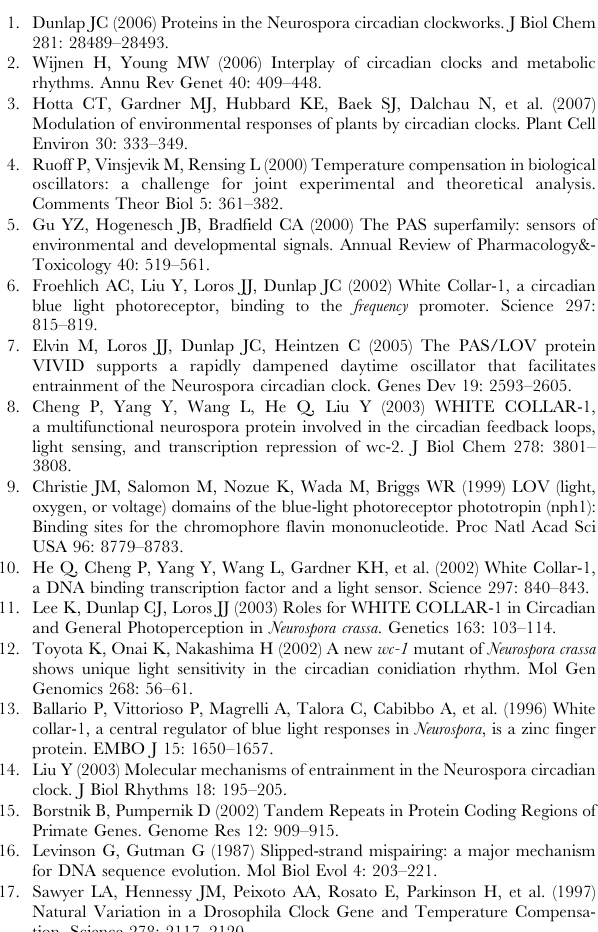
Table S2 Circadian period and phase for progeny of the